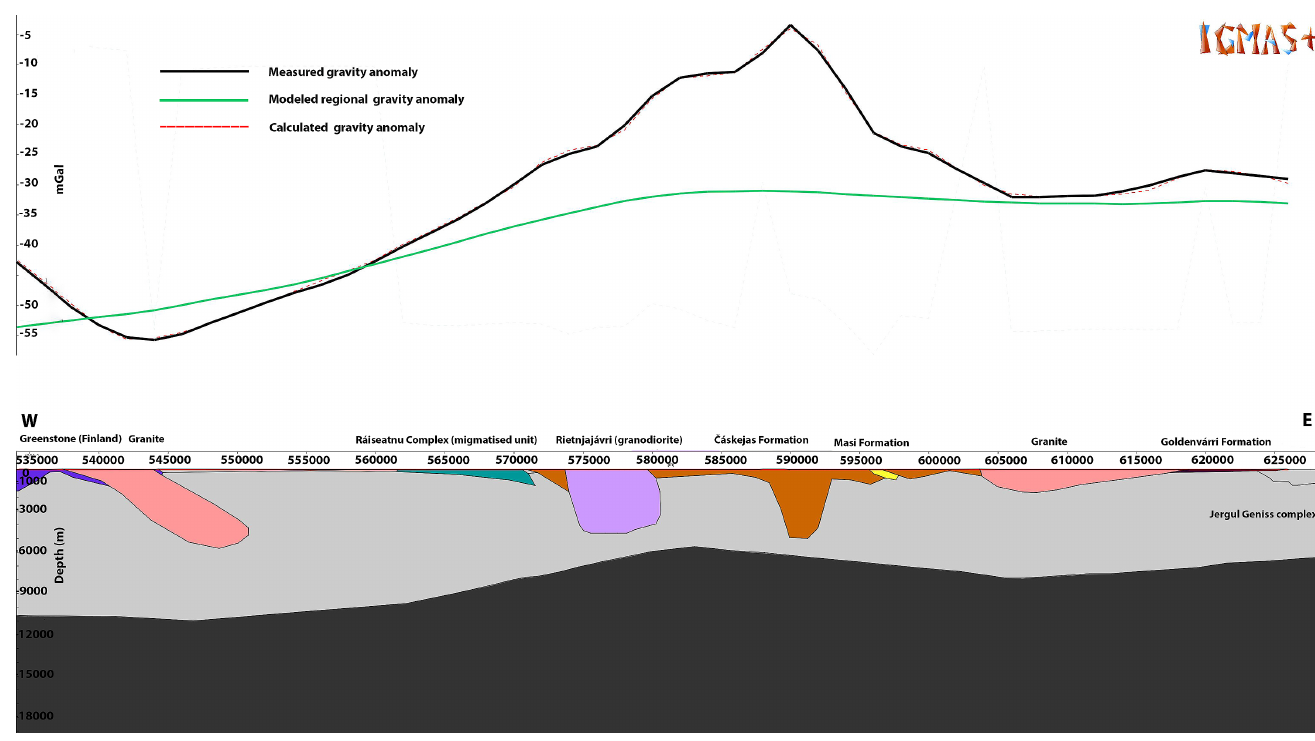
Figure 14. Selected vertical slice P1 through the 3D density/structural model in Fig. 10. The black line shows the measured data. The dashed red line is the modelled data, and the green line shows the regional